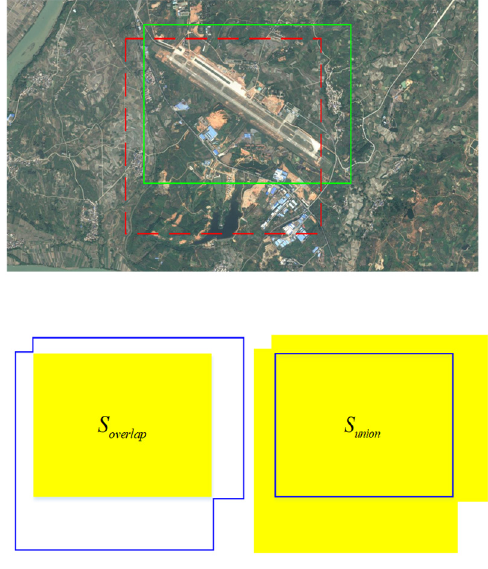
7 of 25 left is the priority box generated during training, and the solid green line box is the target position manually labeled, where overlap S is the overlapping area of the two boxes and union S is the total area covered by the two boxes. Then, defining IoU is described as fol- lows: overlap union S SIoU =